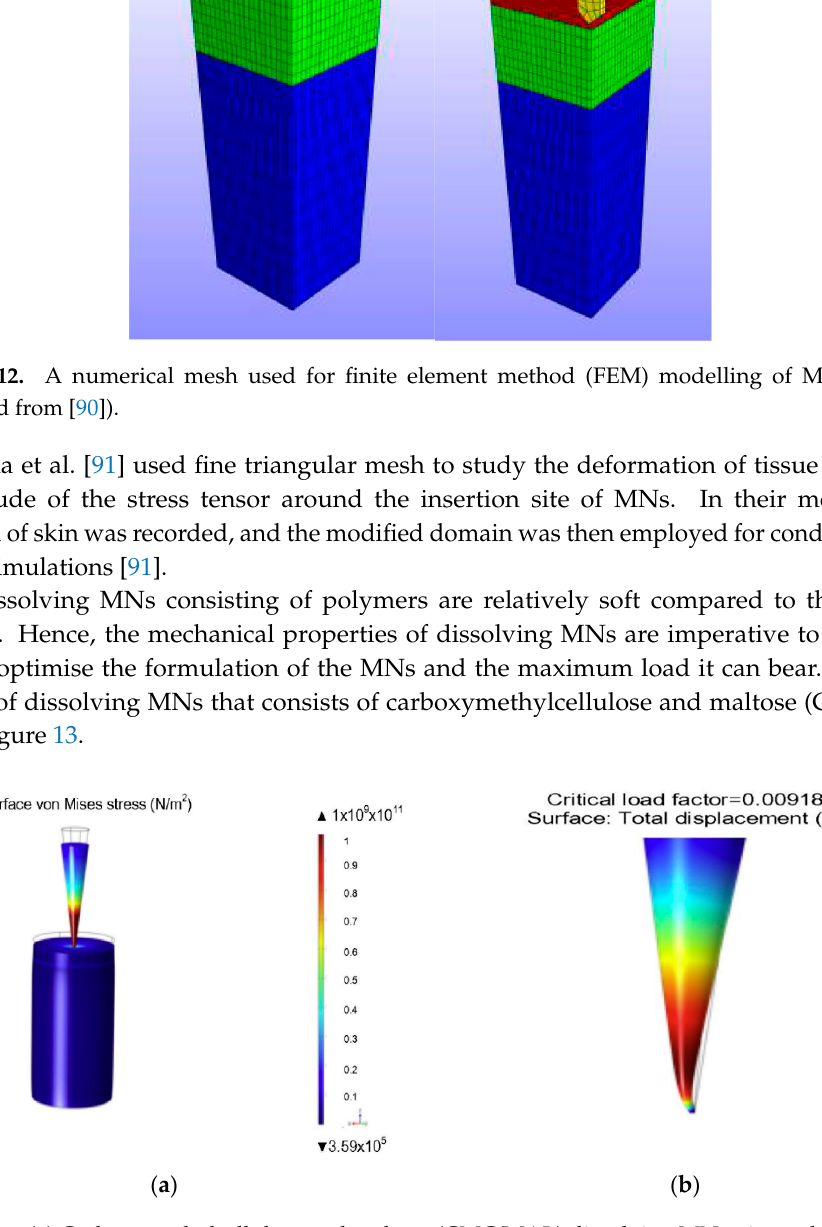
Figure 13. ( a ) Carboxymethylcellulose and maltose (CMC/MAL) dissolving MNs pierce skin sample under 5N load; ( b ) the buckling force is predicted based on the mechanical properties of the MNs (adopted from [88]).